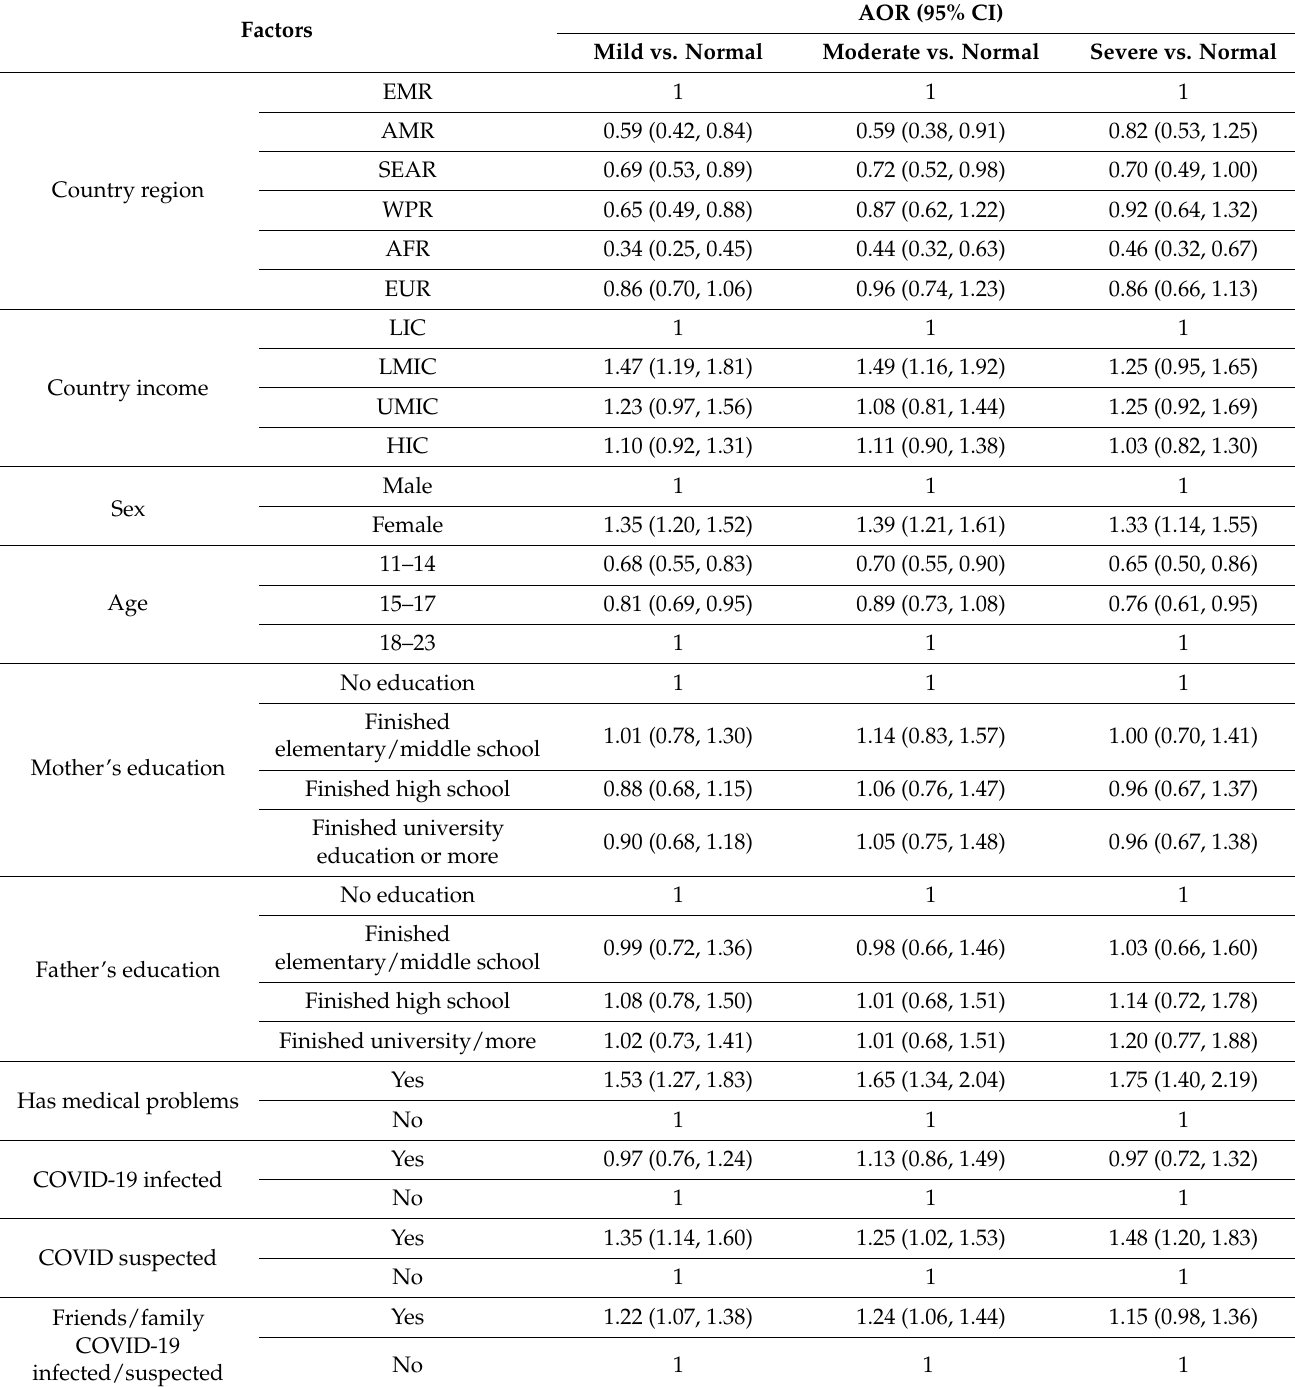
Table 2. Association between country level factors, sociodemographic profile and medical and COVID-19 status and severity of GAD among 11 to 23-year-old individuals from different countries during the second wave of COVID-19 using multilevel analysis ( n = 6989). AOR (95% CI) Factors Mild vs. Normal Moderate vs. Normal Severe vs. Normal